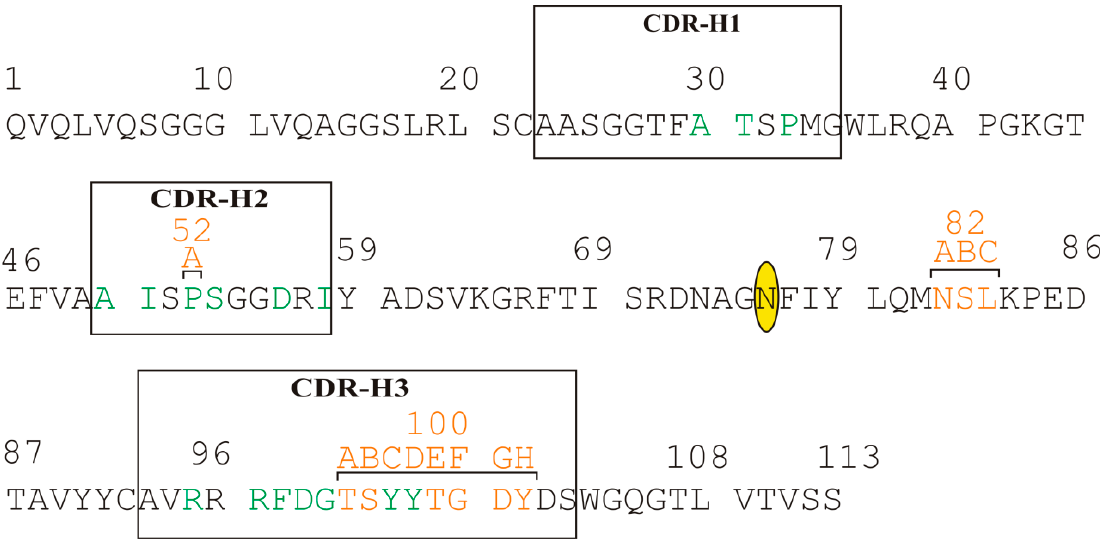
Figure 1. The structure of IL-17A/anti-IL-17A-76 complex (PDB code 8B7W). IL-17A monomers are shown in blue and green, anti-IL-17A-76—in yellow and grey.